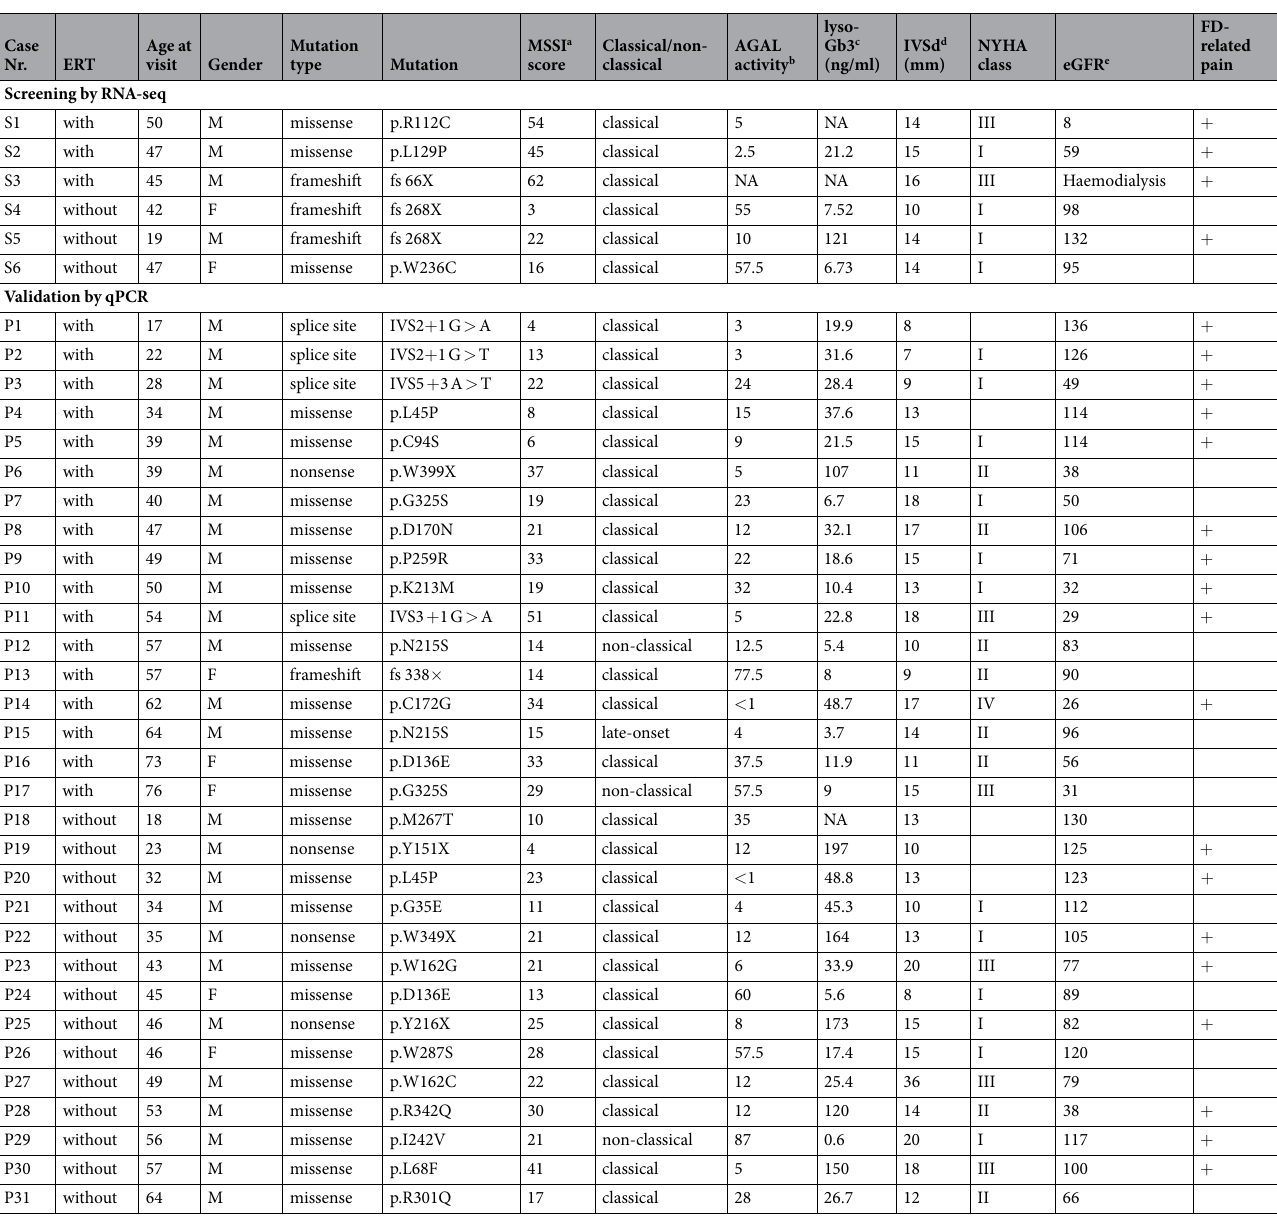
Table 1. Overview of patient groups. a The Mainz Severity Score Index. b The AGAL activities were determined from leukocytes (normal value > 32 nmol MU/h/mg protein) or dried blood spots (normal value > 2.5 µ mol/l/h), patients’ AGAL activities are expressed as % of individual AGAL normal values. c The normal level of lyso-Gb3 in this study is between 0.9–1.9 ng/ml or lower. d Interventricular septal thickness at end-diastole (mm). e Estimated glomerular filtration rate calculated using serum creatinine and the CKD-EPI